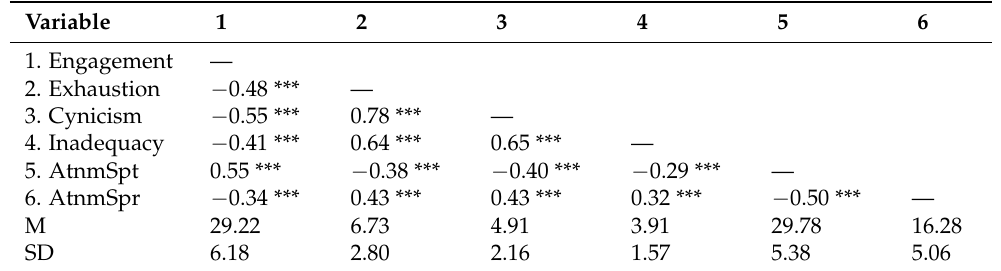
Table 1. Pearson’s correlations among all